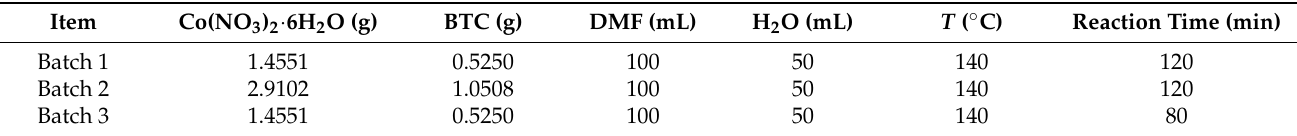
Table 1. Experimental conditions used for the synthesis of KCL-102 (BTC = 1,3,5-benzenetricarboxylic acid, DMF = dimethyl- formide, T =